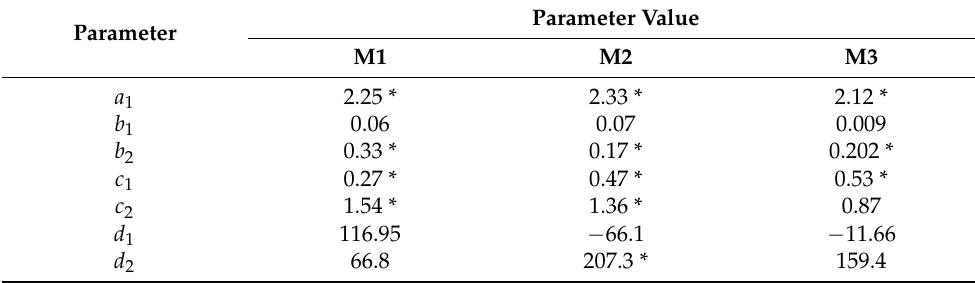
Table 7. Model (5)–(8) parameter estimates for different programs. Parameter